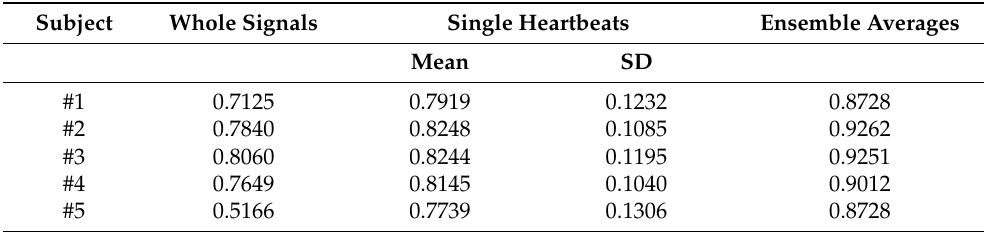
Table 2. Normalized cross-correlation indices between LF-FCG and LF-DSCG signals acquired during quiet breathing. The correlation indices were computed between the whole signals, between single corresponding heartbeats (mean and SD of correlation indices are reported) and between the ECG-triggered ensemble